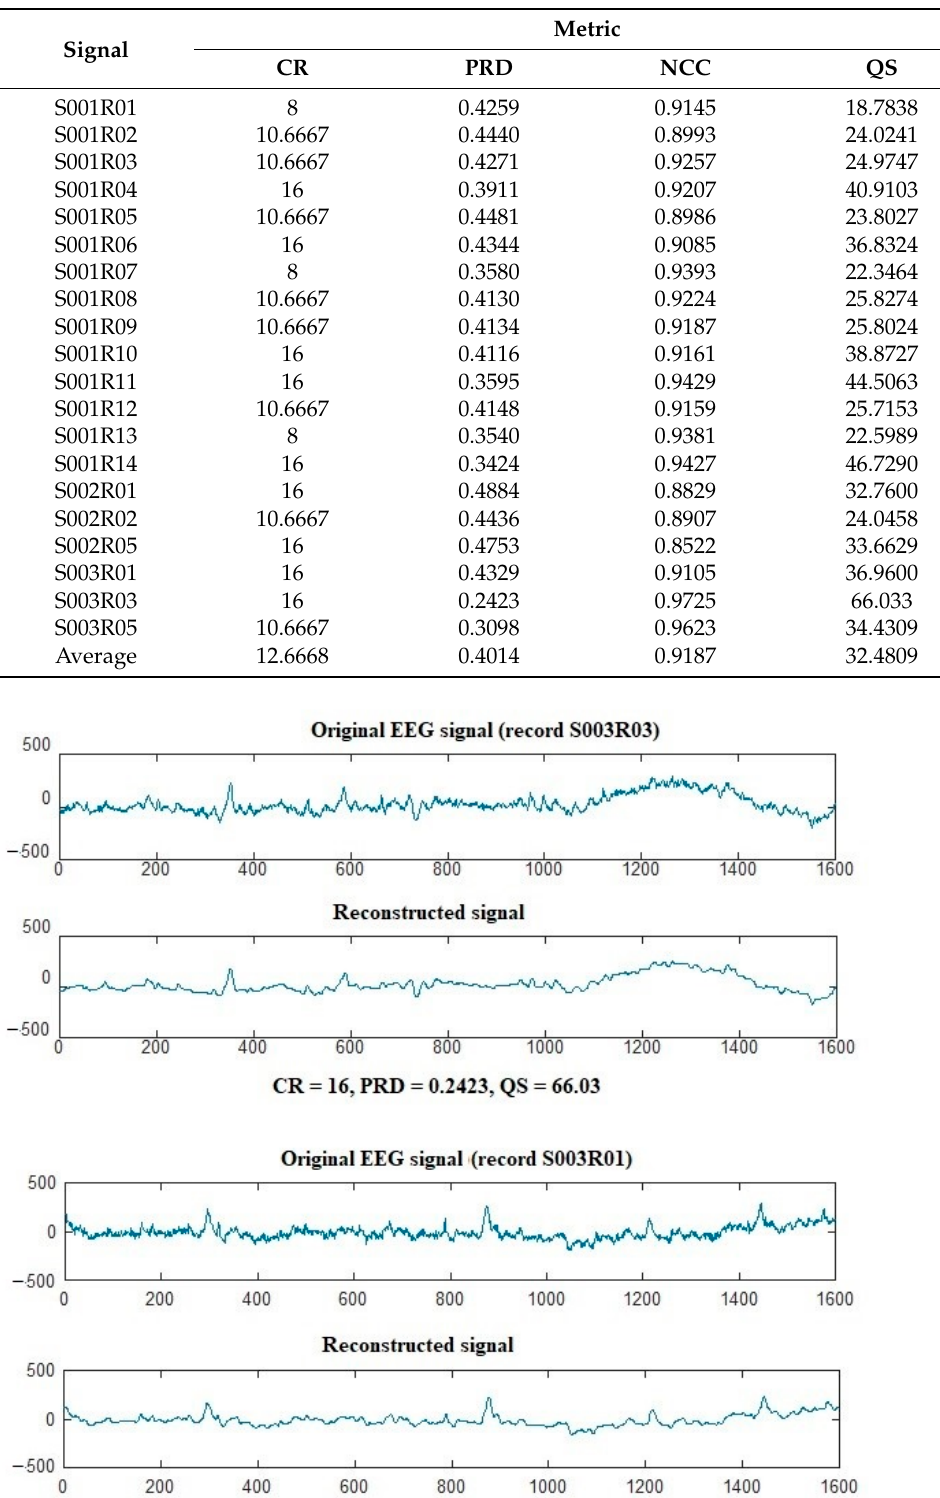
Table 2. Result of EEG signal compression using the proposed algorithm.